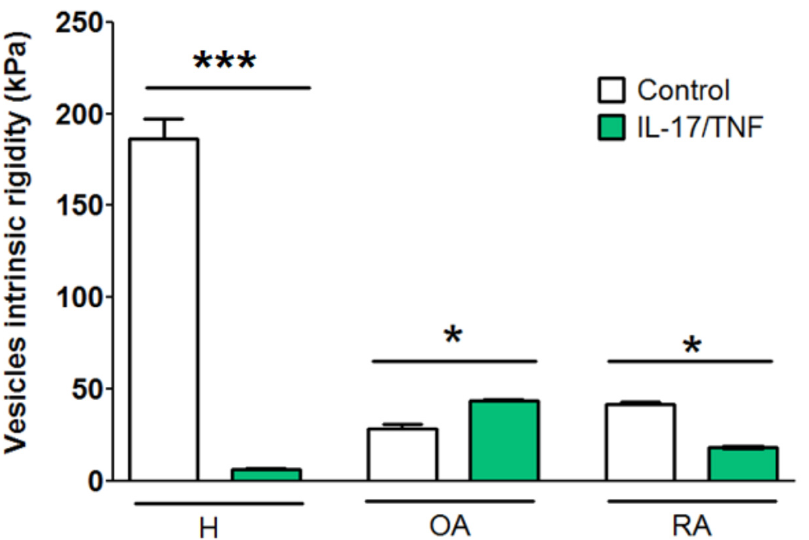
Figure 6. Mechanical characterization of vesicles in supernatant by Atomic Force Microscopy in healthy (H) and pathological conditions (OA and RA) in the absence or presence of inflammatory environment (IL-17: 50 ng/mL, TNF- α : 1 ng/mL). Vesicle intrinsic rigidity as a function of pathology and inflammatory environment compared to control and represented by mean ± SEM. * p < 0.01 and *** p < 0.001.